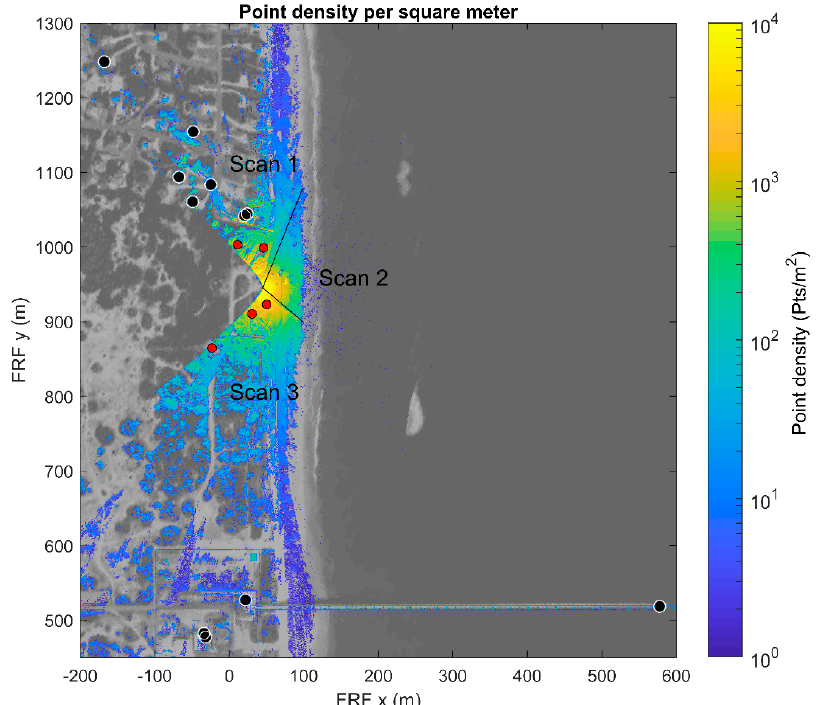
Figure 2. Point density in a merged framescan from 18 September 2015 15:00 UTC. The location of the 11 planes used in the scan co-registration are shown in black and the location of the five reflectors used in the error analysis are shown in red. Black lines indicate the edges of each individual scan in the merged framescan.